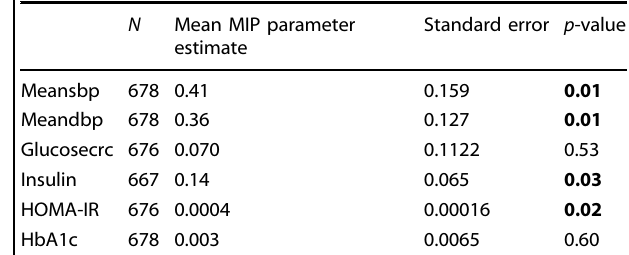
Table 1. Microbial indicator of periodontal disease (MIP) in subgingival plaque ( n = 787) and multiple measures of periodontal